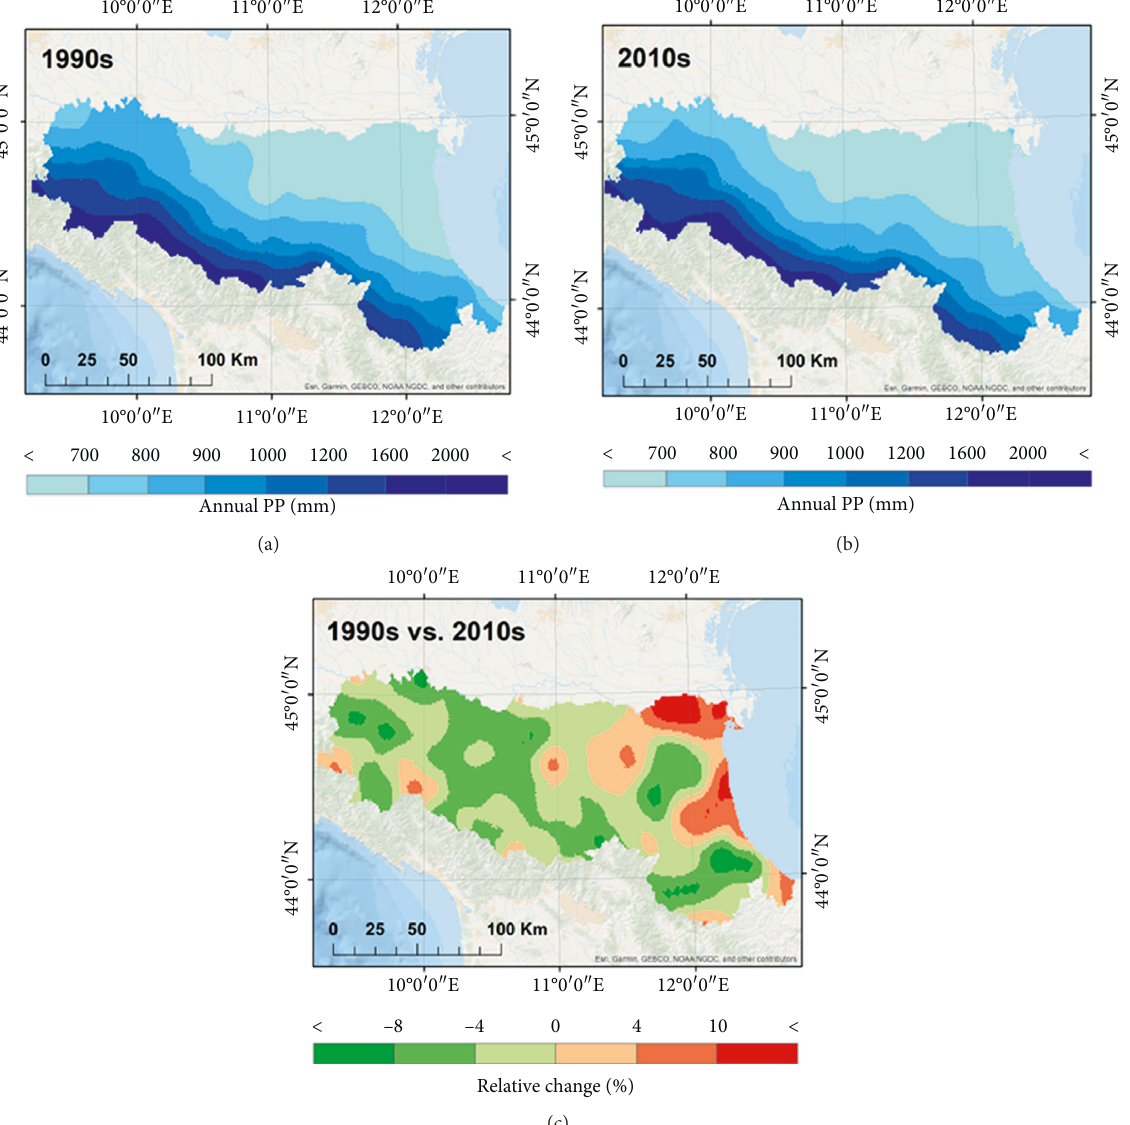
Figure 3: Spatial distribution of mean annual PP. (a) The average of mean annual PP between 1961 and 1990. (b) The average of mean annual PP between 1991 and 2015. (c) The relative changes in mean annual PP as a difference between the two time-periods. Background image source: Esri, Garmin, GEBCO, NOAA NGDC, and other